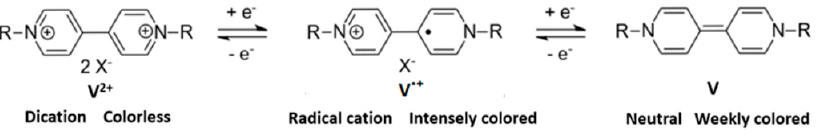
Figure 2. Di ff erent redox states of Figure 2. Different redox states of viologen. Figure 2. Different redox states of viologen.